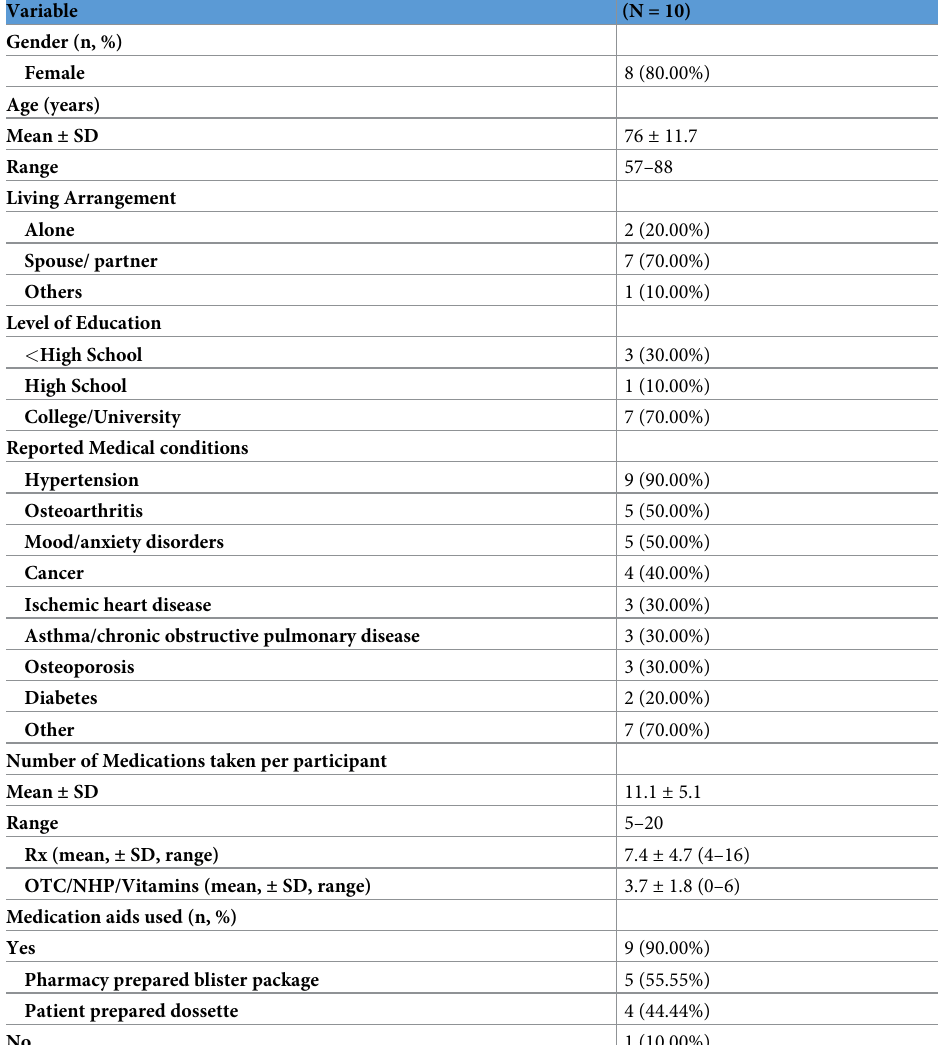
Table 1. Demographic characteristics of